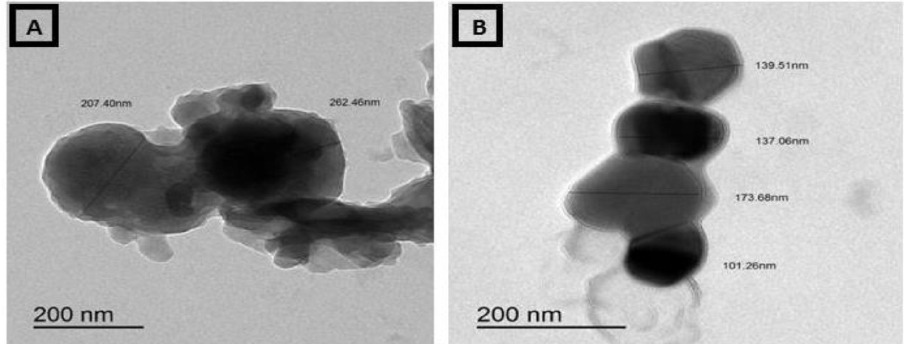
Figure 7. TEM of ammonium molybdate ( A , B ).